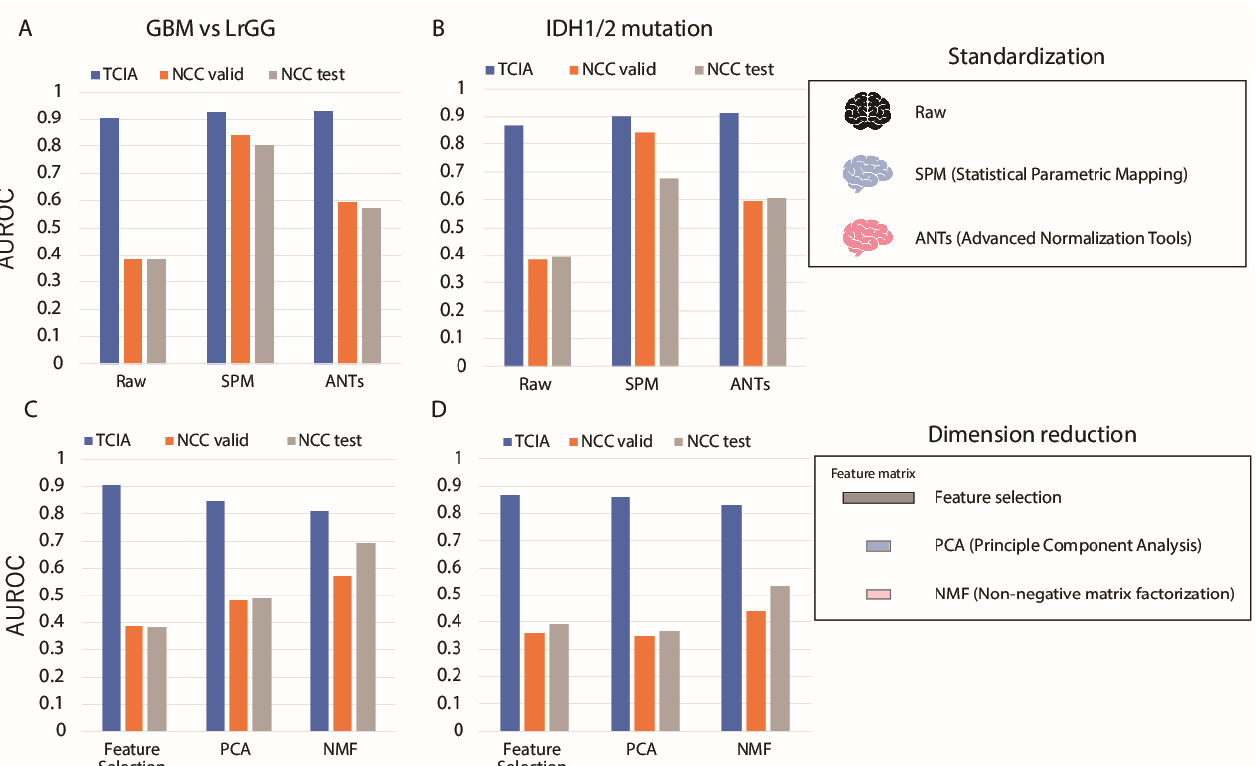
Figure 4. Changes in the classification performance of GBM ( A , C ) and IDH ( B , D ) prediction when standardization or dimension reduction methods were changed. ( A , B ), Changes in the accuracy of GBM and IDH prediction due to differences in the standardization method. Blue, orange, and gray bars correspond to TCIA cross validation, NCC validation, and NCC test accuracies, respectively. ( C , D ), Changes in the accuracy of GBM and IDH predictions due to differences in the dimension reduction method.